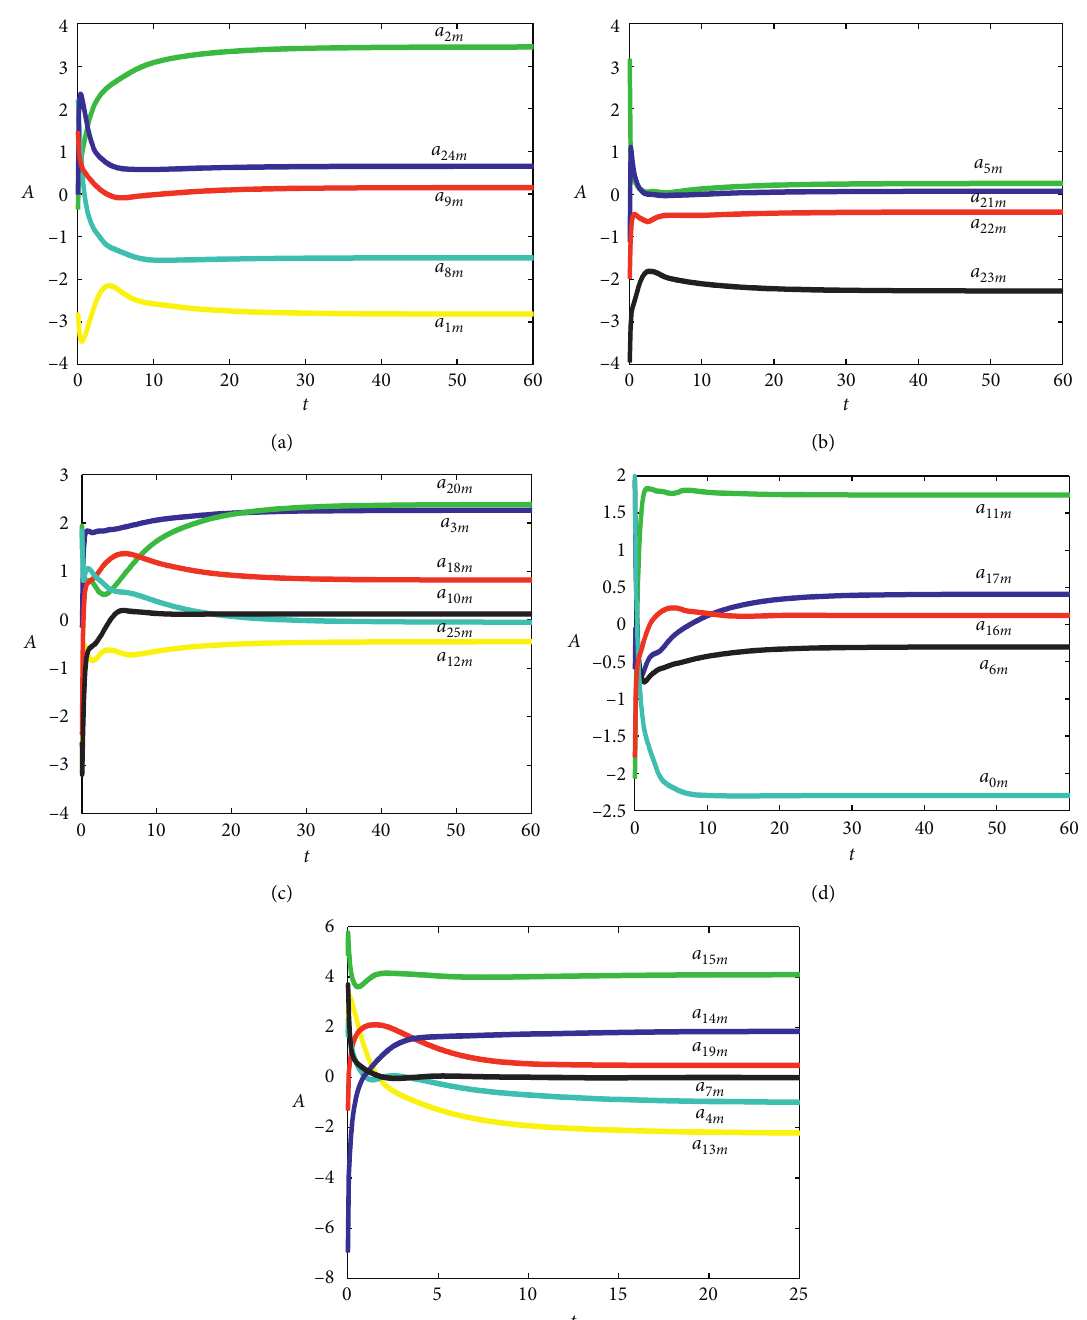
Figure 2: Transient behaviors of a